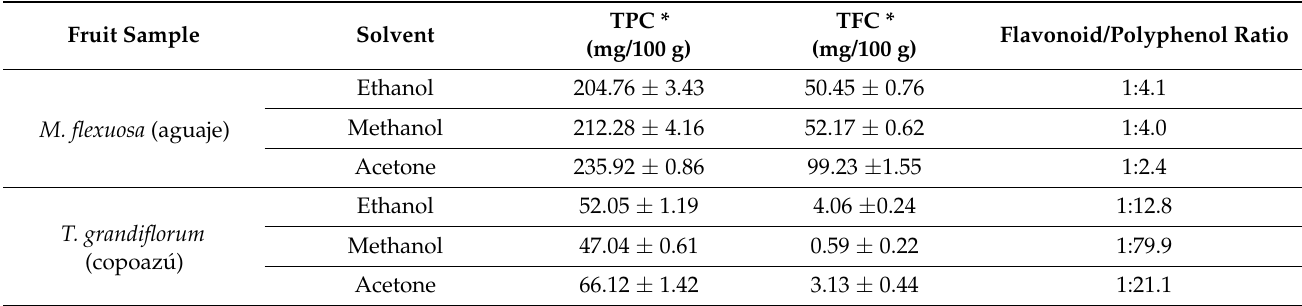
Mean values for TPC* (mg of gallic acid equivalents) and TFC* (mg quercetin equivalents) per 100 g of fresh pulp ± stand-